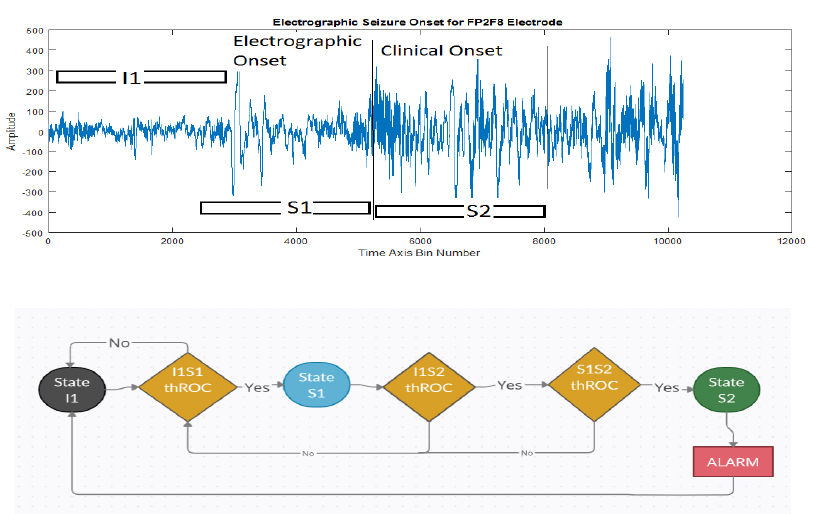
Figure 8. The 3RF classifier-based state machine. The th roc value is determined at each stage of the state machine.